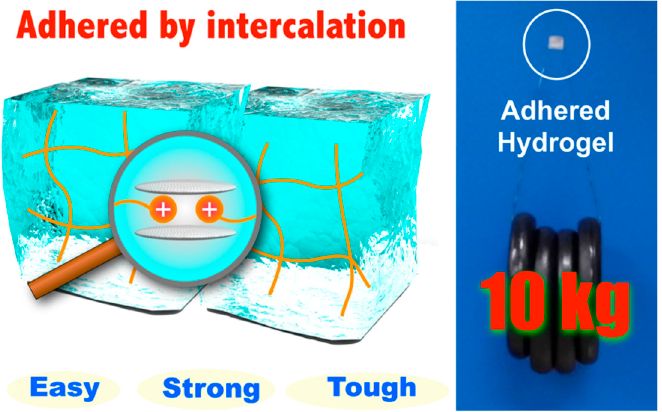
Figure 4. Schematic representation of high concentration cationic gels adhered using 1.6 mg of Micromica supporting a tensile load of 10 kg. Reprinted from [81] with permission from the American Chemical Society (2016).